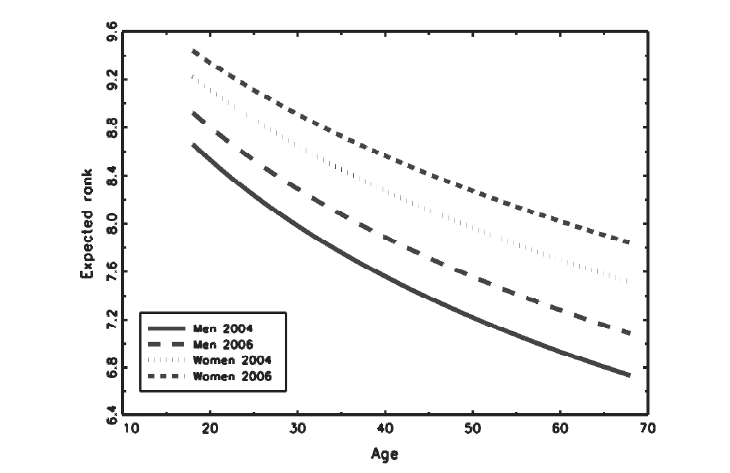
Figure 8 – Expected rank, given Gender and Time, for varying